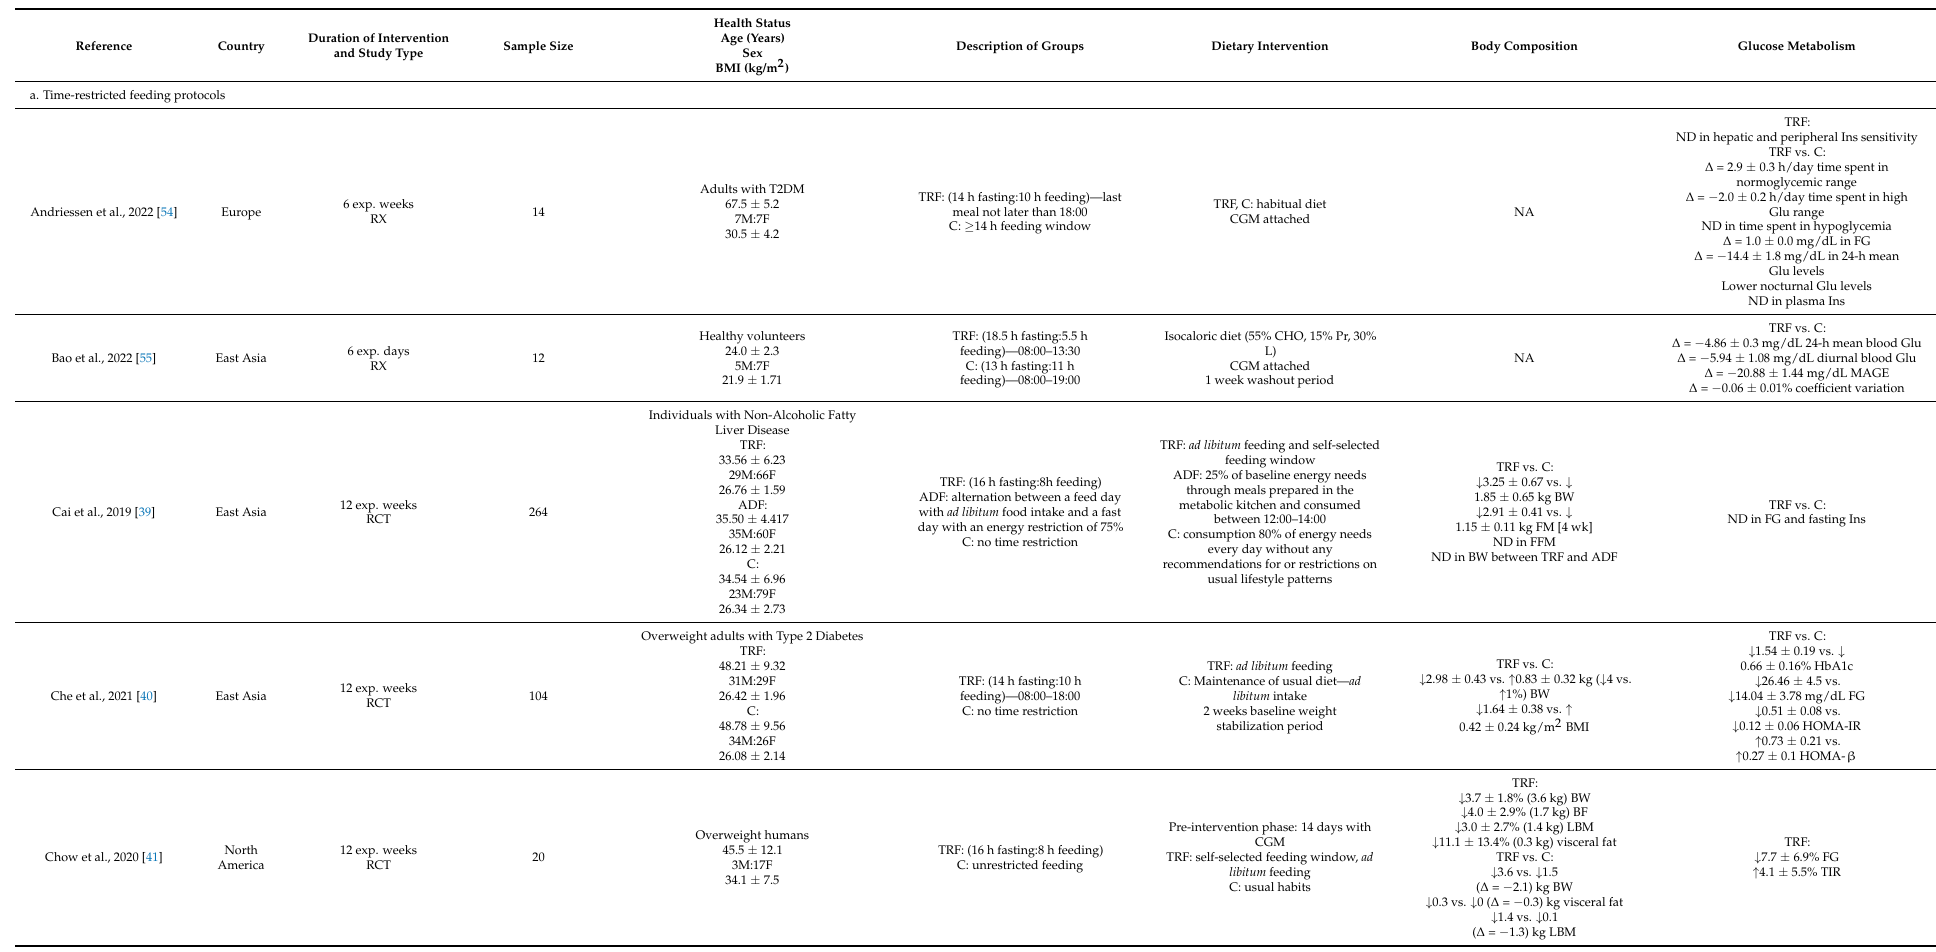
Table 1. Characteristics of the studies included in the